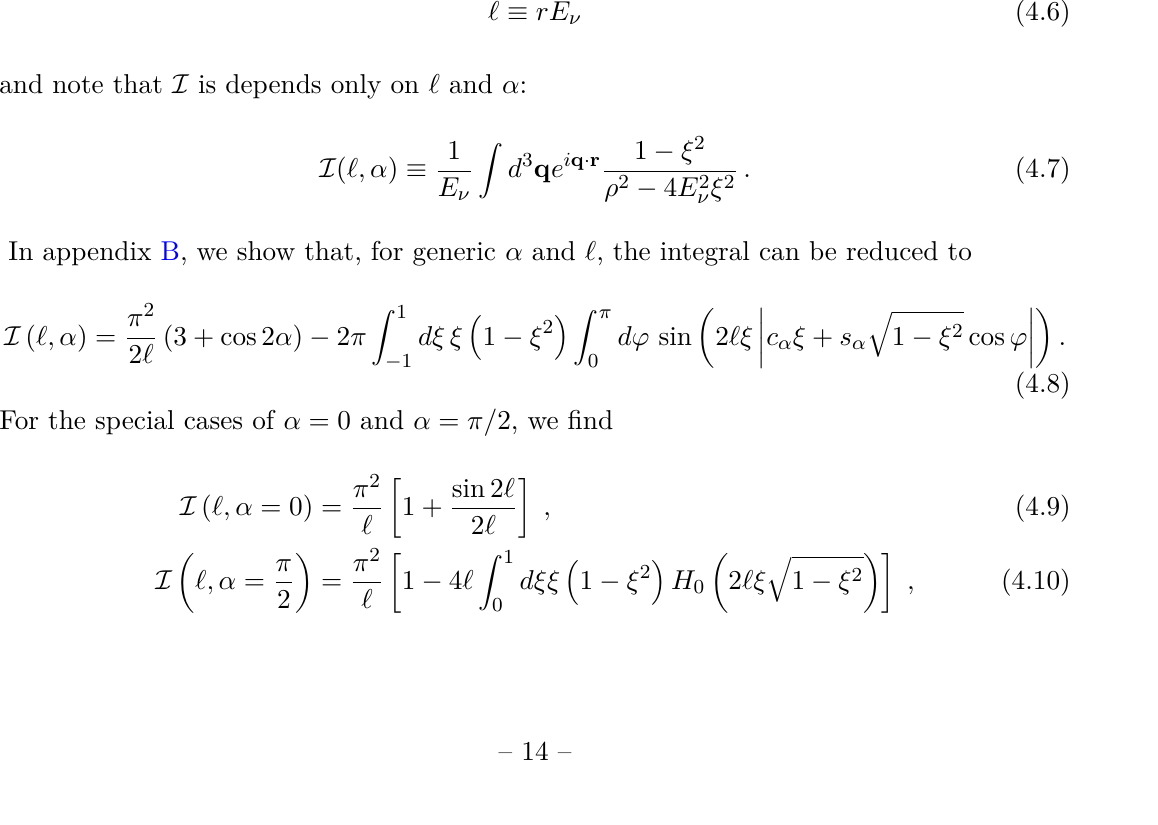
while the background potential V ( r, α ) bkg ν Φ , has been omitted g 1 g 2 0 E ν F V V